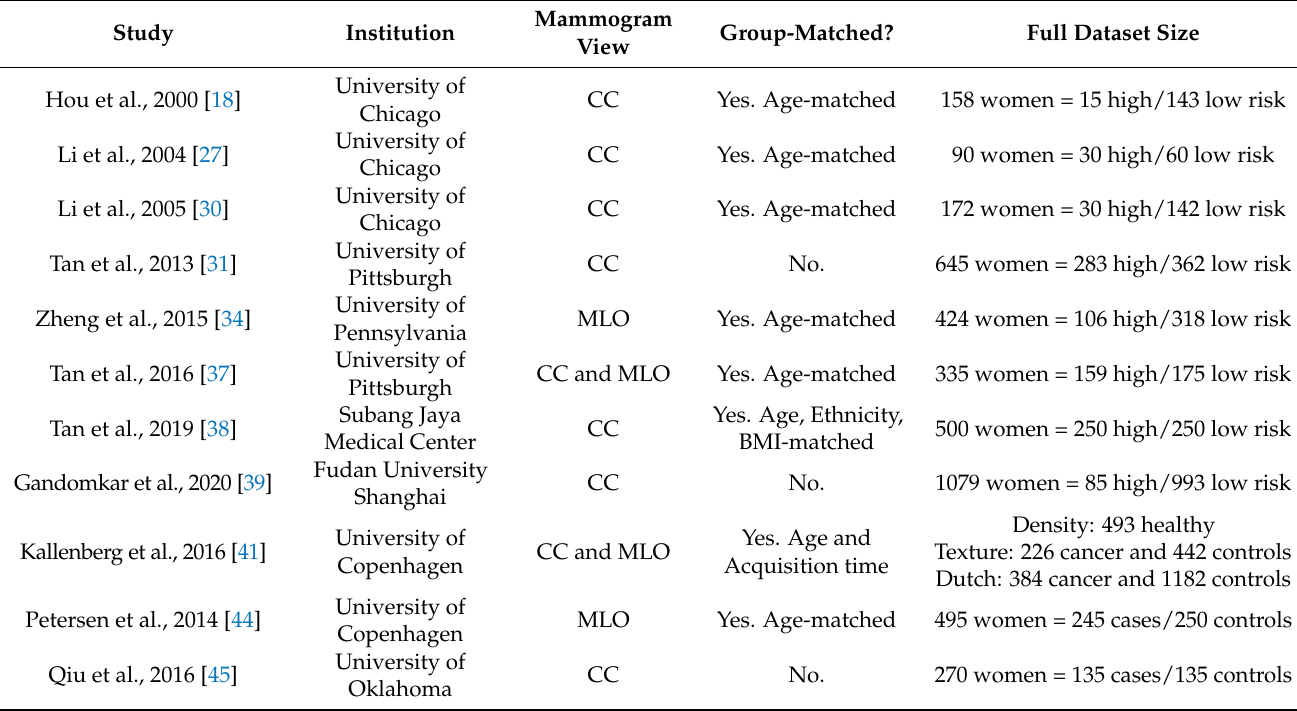
Table 1. Studies Data Summary.